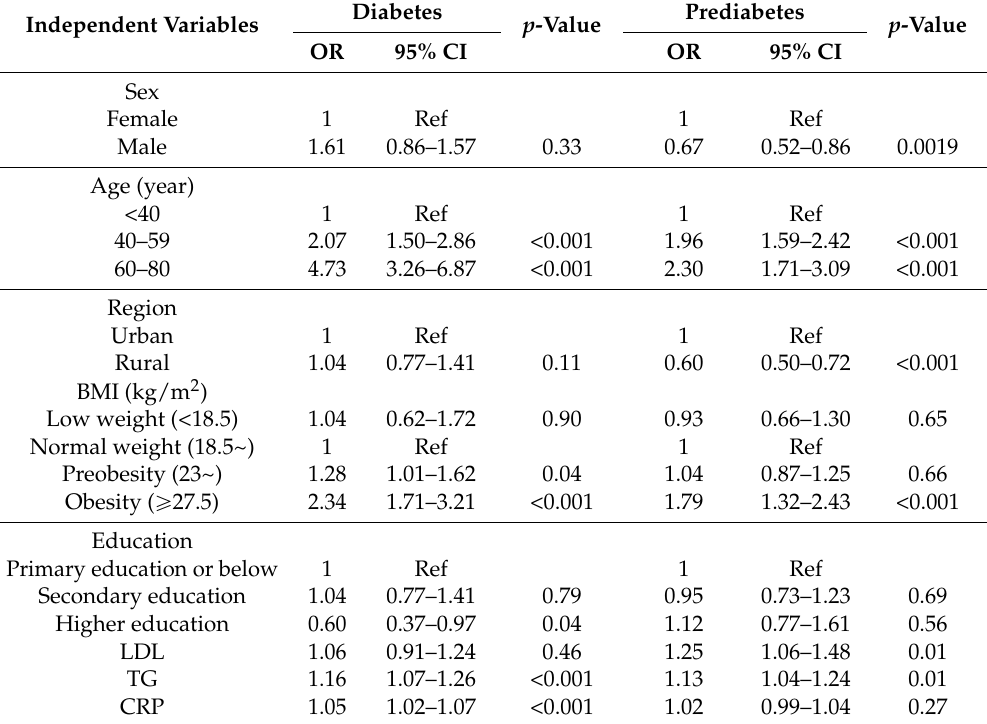
Table 4. Logistic regression analysis for the associated factors of patients with diabetes or prediabetes. Diabetes Prediabetes p -Value p -Value Independent Variables OR 95% CI